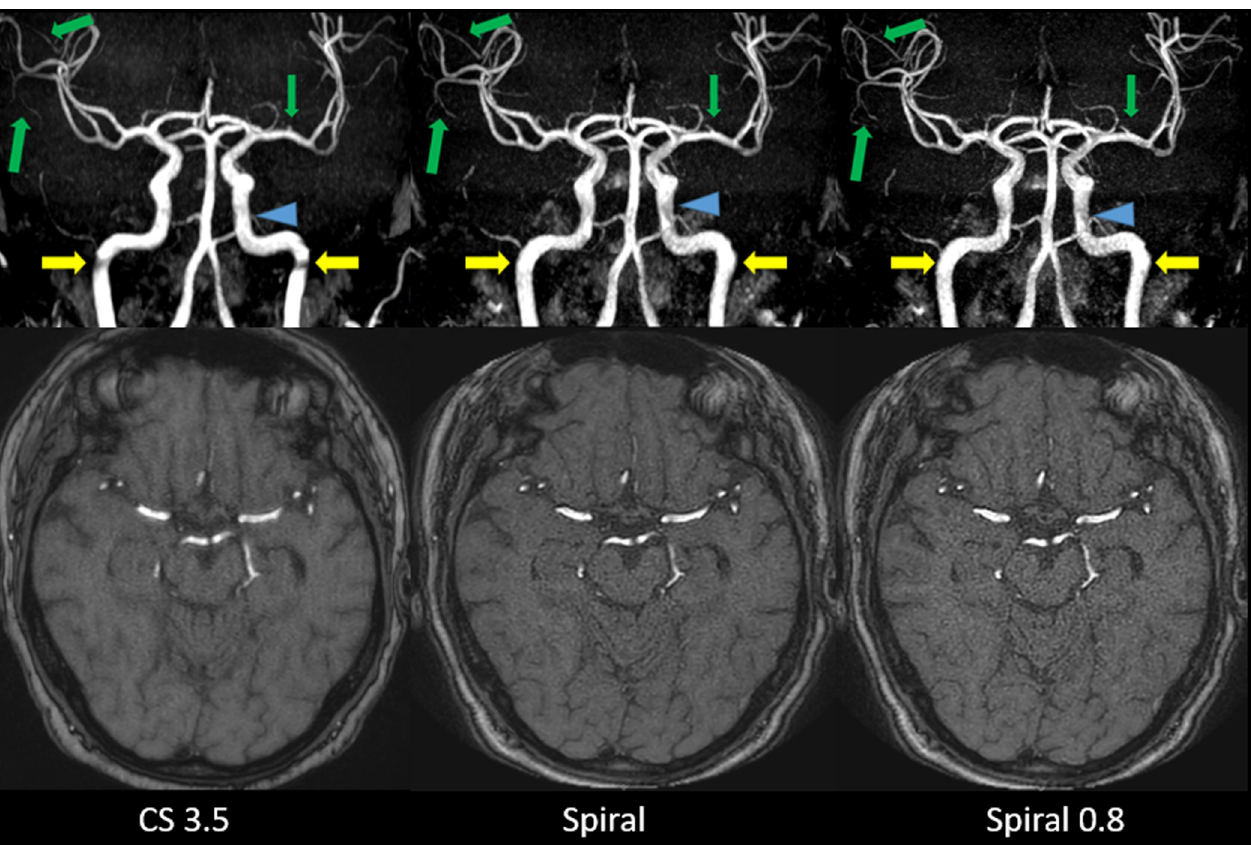
Fig 2. Coronal whole volume MIP and source images of CS 3.5 (A), Spiral (B) and Spiral 0.8 (C). Artifacts at the turn of the vertical to the horizontal petrous segment of both internal carotid arteries are reduced on both Spiral-TOFs compared to the CS 3.5 (yellow arrows). However, slightly more inhomogeneous central signal in the cavernous segment of the left internal carotid artery (blue arrowheads) can be seen on both Spiral-TOFs compared to the more homogeneous central signal on the CS 3.5 TOF. As for peripheral vessels, inconsistent depiction of small arterial branches arising from the M2 and M3 Segments of the right middle cerebral artery and from the M1 segment of the left middle cerebral artery can be seen on the CS 3.5 compared to consistent depiction on both Spiral-TOFs (green arrows).